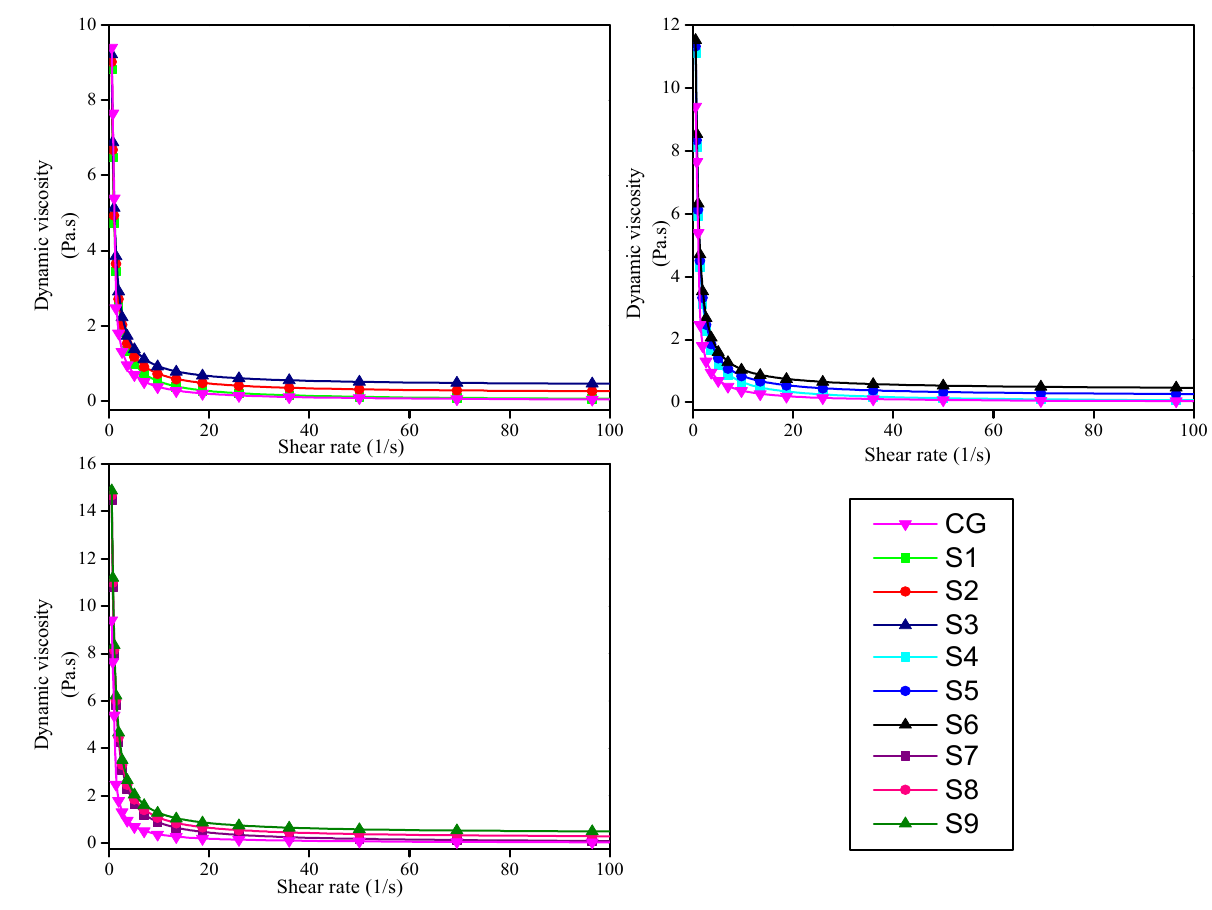
Figure 7. Dynamic viscosity (Pa.s) of all formulations when compared to commercial gel at different shear rates (1/s).